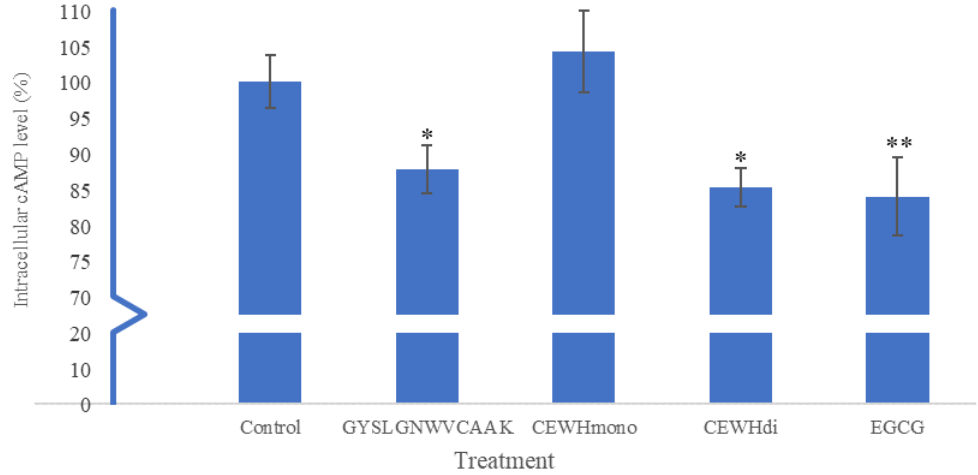
Figure 5. Effects of 10 µg/mL of GYSLGNWVCAAK, CEWH mono , CEWH di and EGCG on the intra- cellular cAMP level of B16F10 melanoma cells. Note: Results were reported as the mean ± standard deviation ( n = 3); * indicates p < 0.05 and ** indicates p < 0.01, which were significantly different to the untreated control group according to Dunnett’s test.